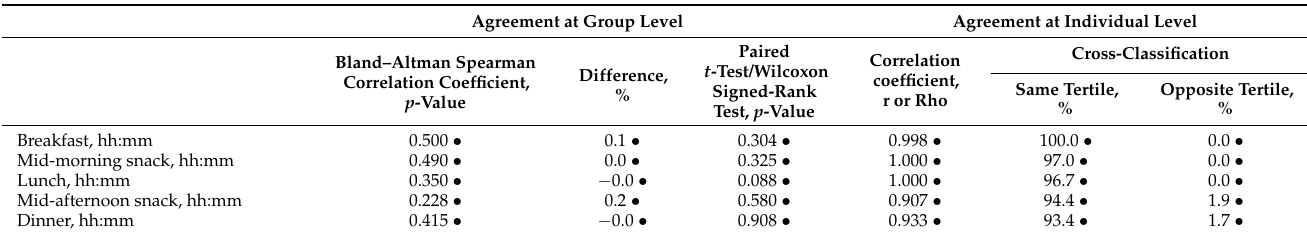
Table 3. Summary of statistical test outcomes and interpretation of meal timings to assess the relative validity of Remind app.